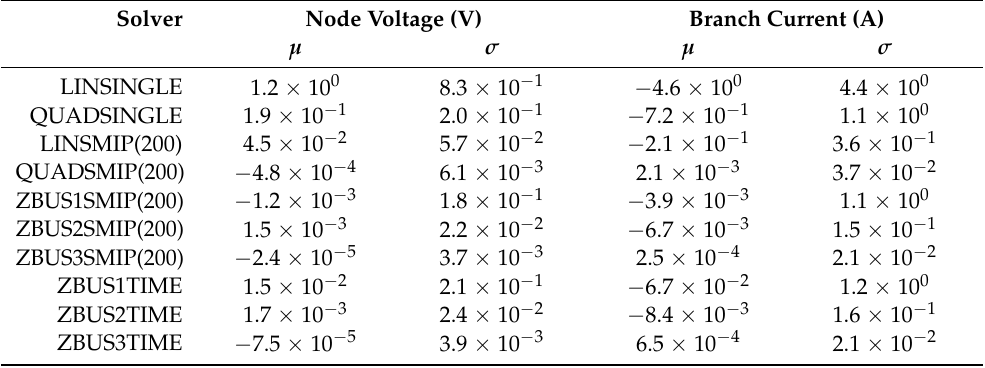
Table 5. Overall solver accuracy as measured by the mean bias ( µ ) and standard deviation ( σ ) of the